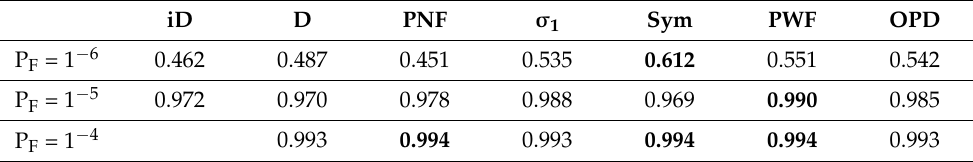
Table 4. Probabilities of detection for dual-polarimetric open ocean. Bold numbers indicate highest P D values.